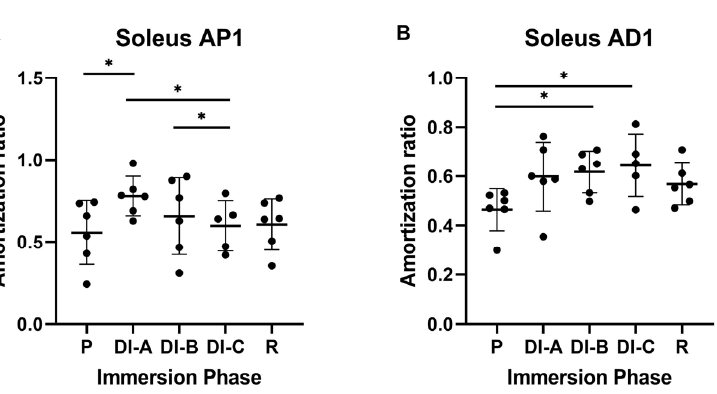
Figure 7. Amortization ratio for Sol: ( A ) close proximal propagation (P1) and ( B ) close distal propagation (D1). The statistical significance of results is noted with an asterisk (*): * p < 0.05.